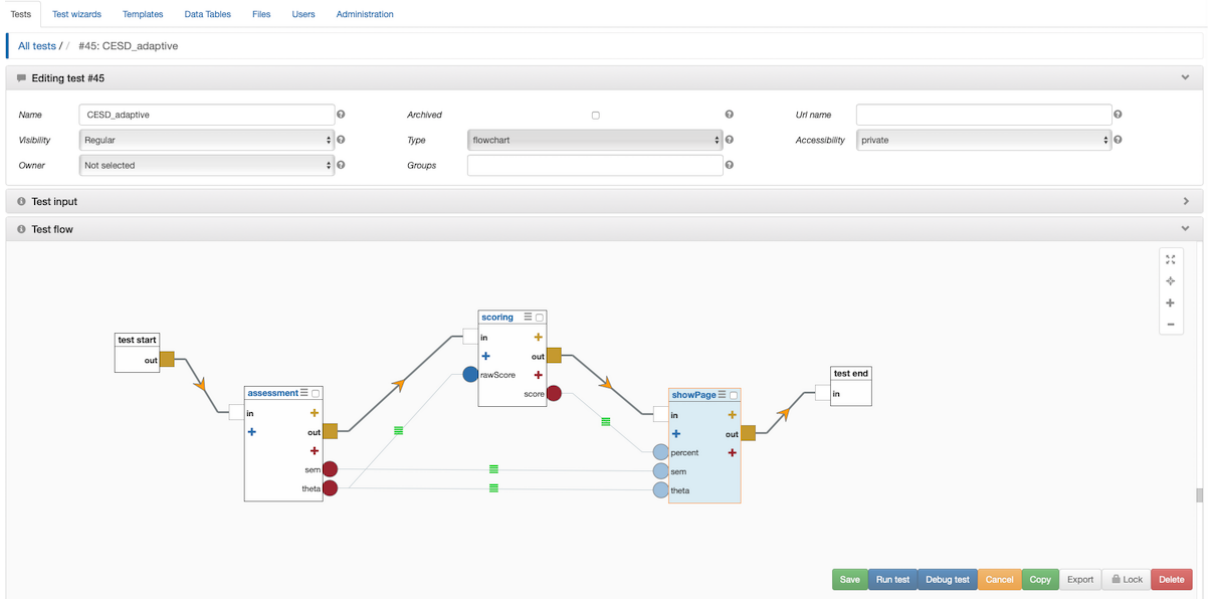
Figure 3. Concerto screenshot: connecting